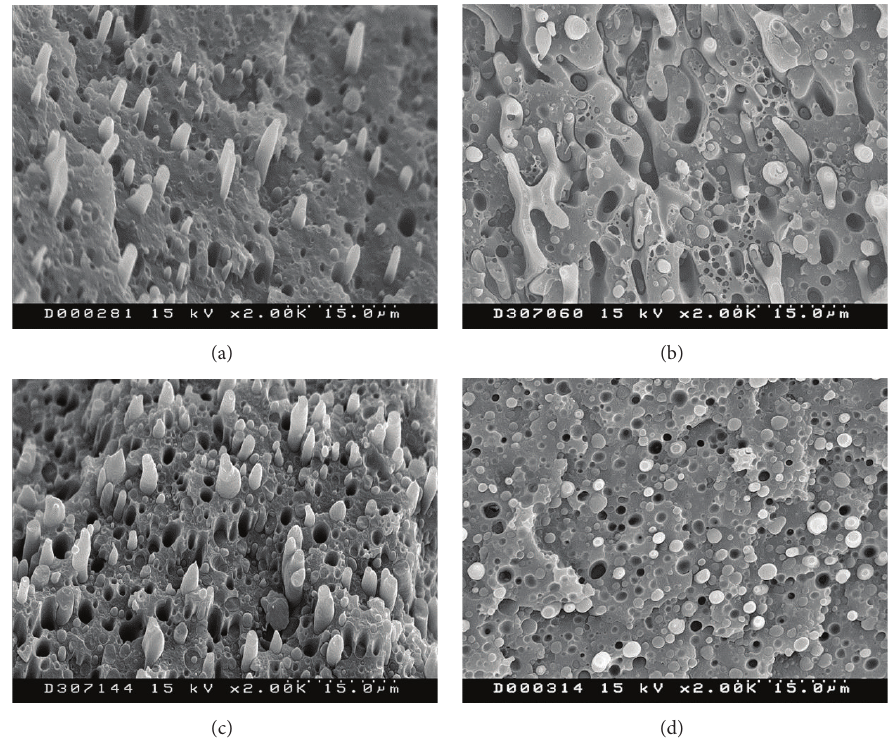
Figure 3: SEM micrographs of (a) 75/25, (b) 60/40, (c) 40/60, and (d) 25/75 PP/PA12 blends, taken with incidence angle of 40 ∘ (a and c) and 0 ∘ (b and